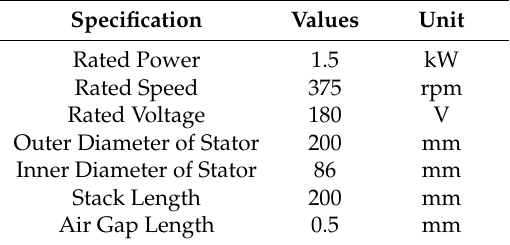
Table 1. Design specifications of the dual rotor radial flux (DRRF) wind